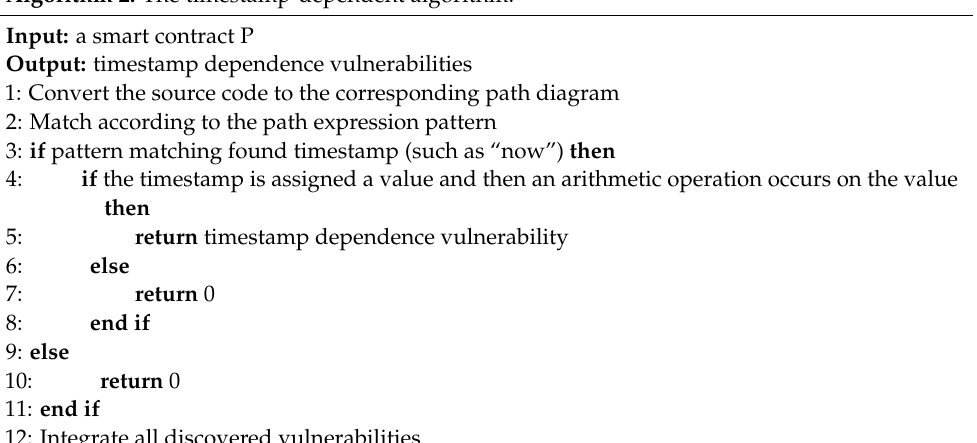
Algorithm 2: The timestamp-dependent algorithm.